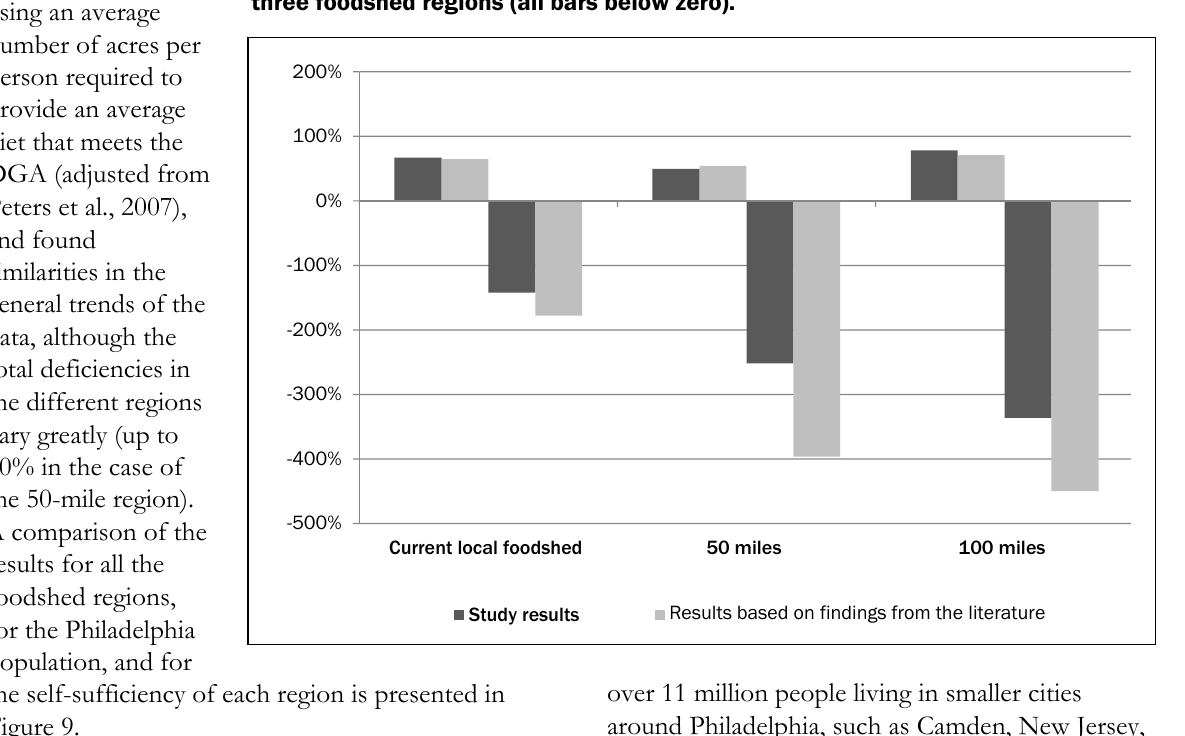
Figure 9. A comparison of the results of this study and results using literature data (from Peters et al., 2007) for the defined foodshed regions’ capacity to support food requirements of the Philadelphia population (all bars above zero) and the three foodshed regions (all bars below